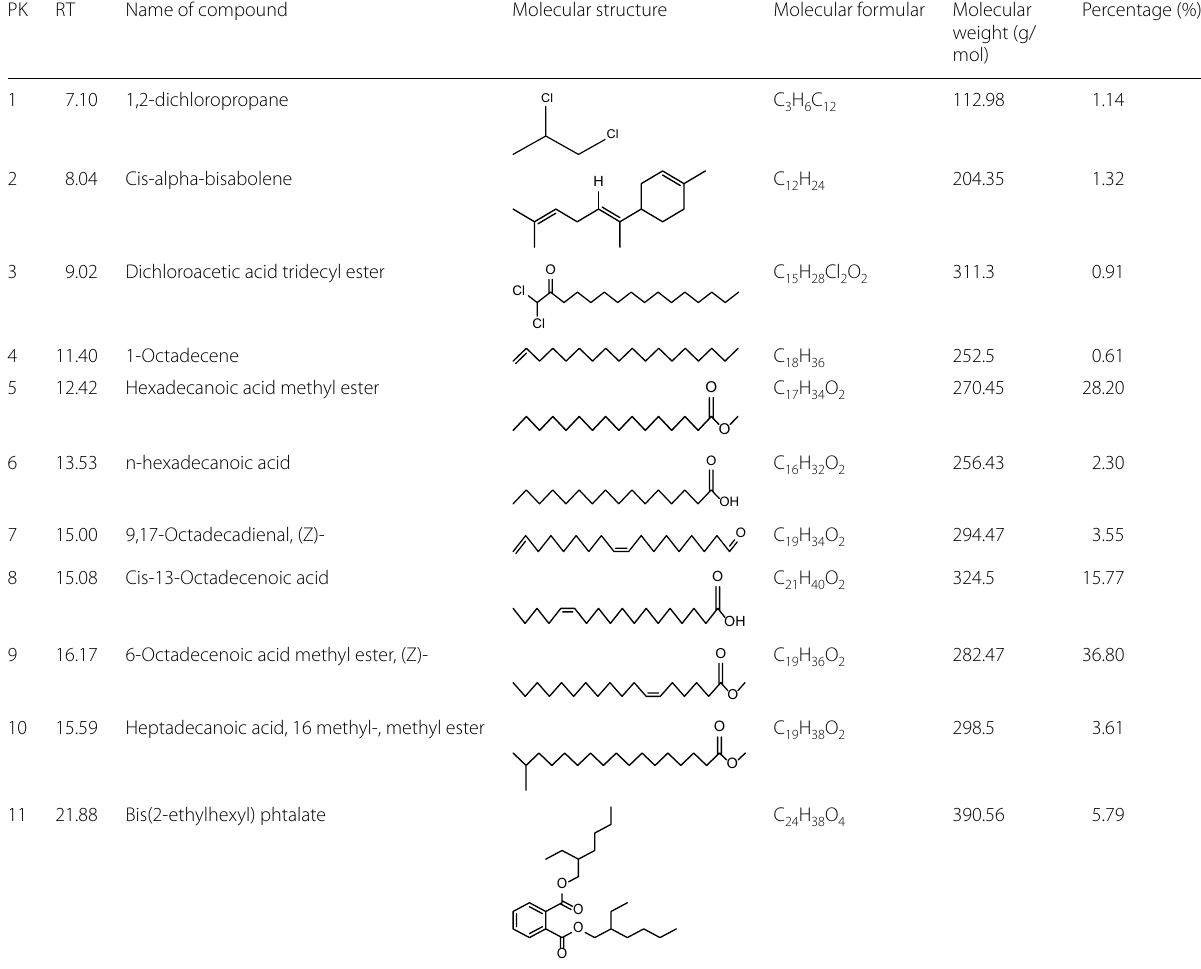
Table 9 Compounds identified in GC–MS analysis of methanol extract of D.arborescens roots PK RT Name of compound Molecular structure Molecular